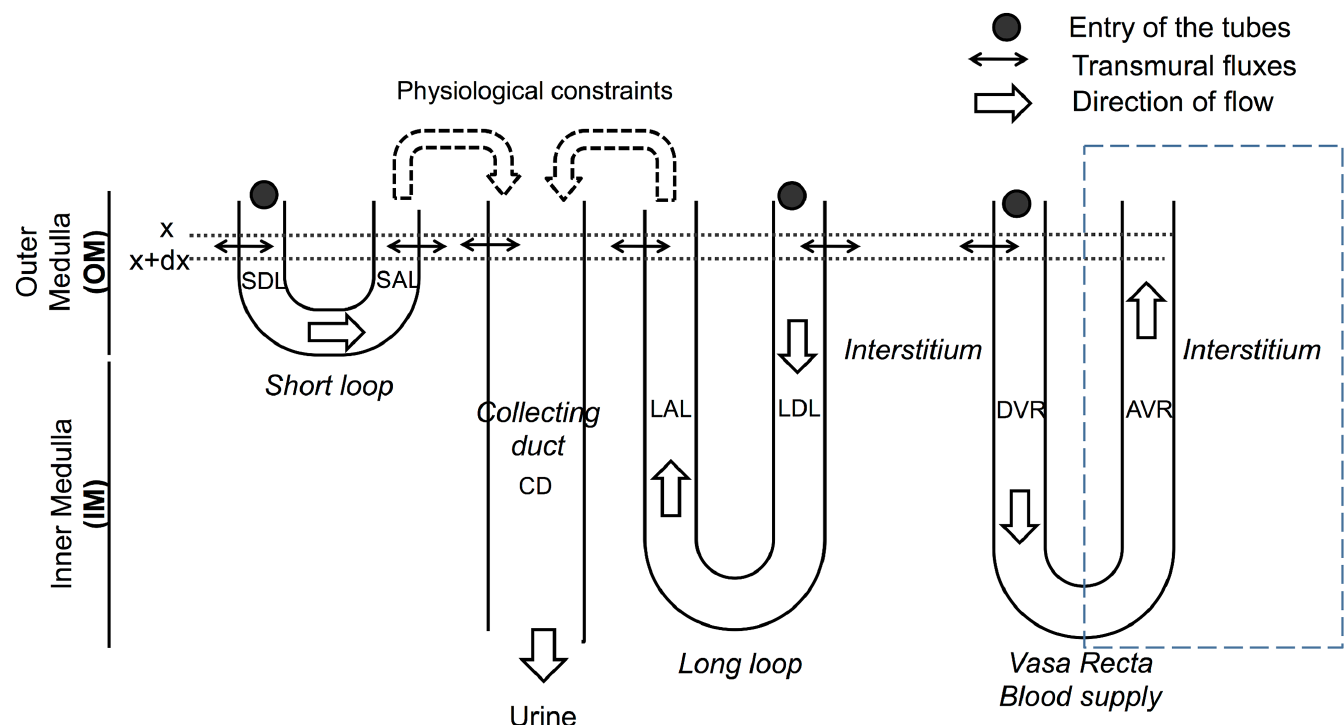
Fig 1. Schematic diagram of the model: medullary structures. The model distinguishes short and long nephrons. The flows are set at the entry to the descending limbs and vasa recta (solid circles). Flows are then calculated along each tube using the equations for transmural fluxes. Inflow to the collecting ducts (CD) is calculated from the flows leaving the ascending limbs and under some physiological constraints (see [17] and text). The ascending vasa recta (AVR) is lumped with the interstitium. The figure does not depict the virtual shunts within the inner medulla that connect the descending and ascending part of the loops of Henle and vasa recta; these shunts are used to replicate the experimentally observed decrease in the number of tubes within the inner medulla. SDL: short descending limb, SAL: short ascending limb, LAL: long ascending limb (includes the thin ascending limb in the IM and the thick ascending limb in the OM), LDL: long descending limb, DVR: descending vasa